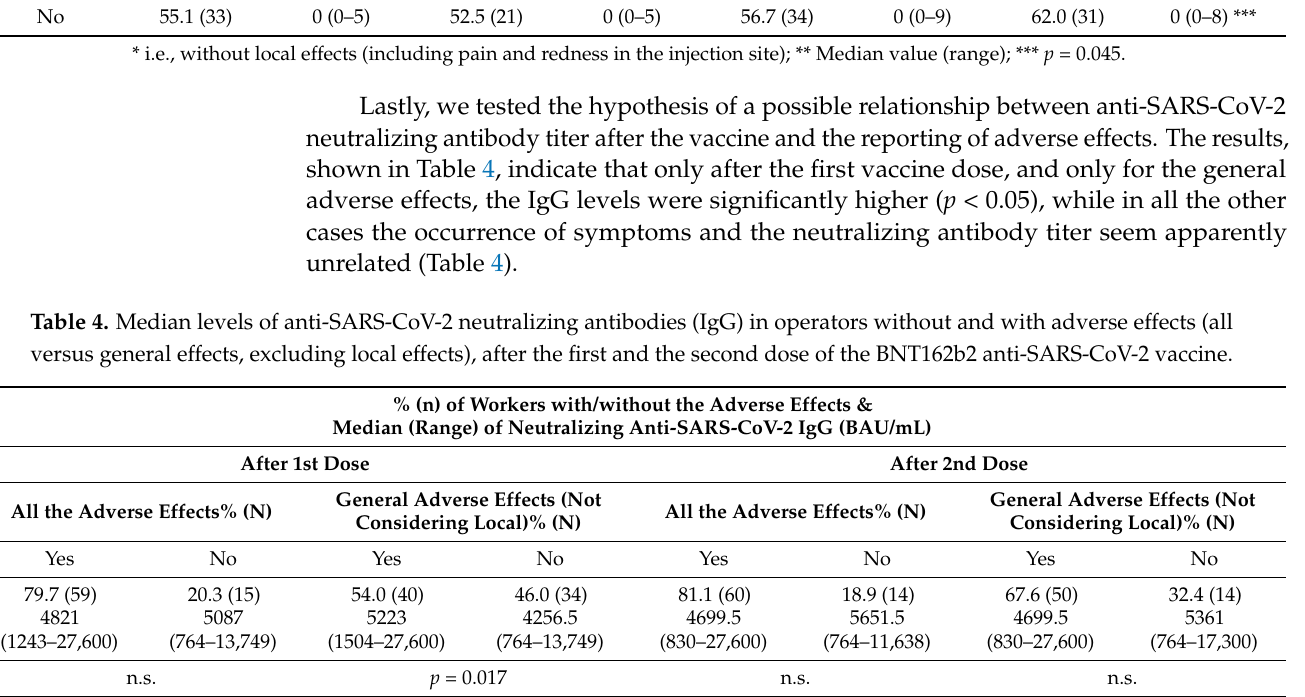
Table 3. Adverse effects (all versus general effects, i.e., excluding local effects) lasting more than 24 h after the first and second dose of BNT162b2 anti-SARS-CoV-2 vaccine in the workers with and without a previous COVID-19 diagnosis. After 1st Dose After 2nd Dose All the Adverse Effects Previous COVID-19